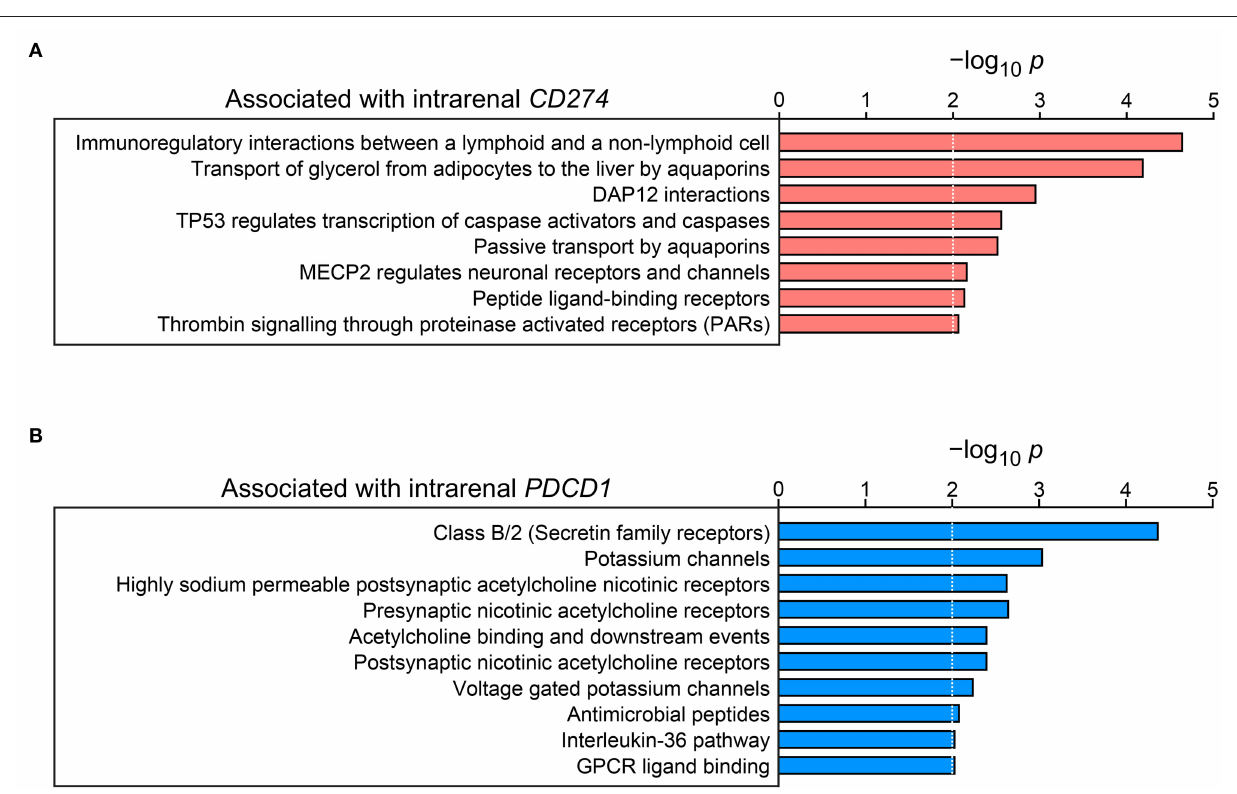
Frontiers in Medicine |